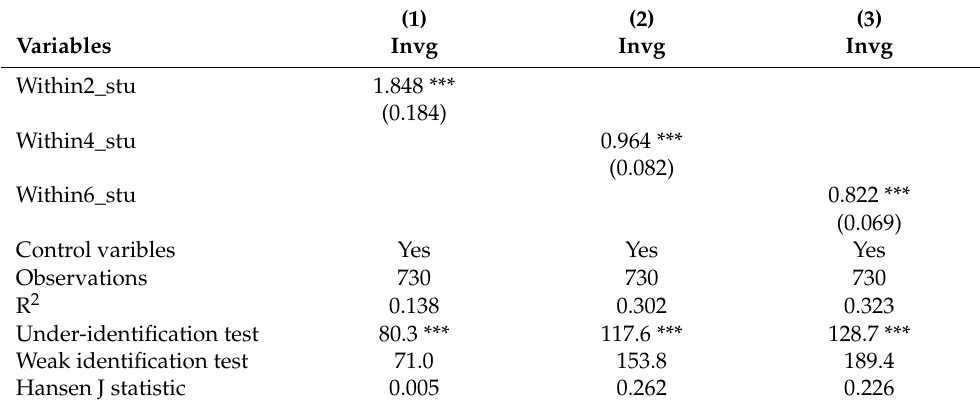
Table 3. IV model results explaining the impact of the university student proportion of the cities to that of the region by HSR within 2, 4, and 6 h on invention patents